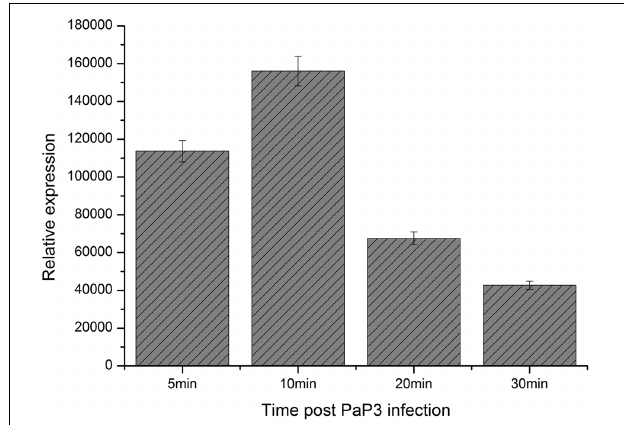
FIGURE 2 | RT-qPCR analysis for detecting the relative expression of orf70.1 during infection of host bacteria by PaP3.